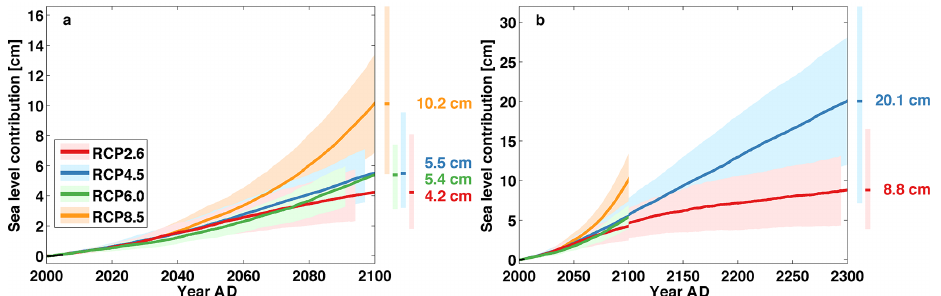
Figure 7. Greenland ice sheet contribution to future global sea-level change. Given are ensemble averages for each scenario during the 21st century (a) and the next 3 centuries (b) . The modelled rate of mass loss during the observational period (2000–2010) is on average 0.32mmyr − 1 . Colours indicate the respective RCP scenario and the lighter background colour represents 1 standard deviation from each mean trajectory. Vertical bars indicate the spread of sea-level contributions arising from individual AOGCMs at the end of each scenario. The jump across the year 2100 in the right panel arises from the use of a different number of climate models in simulations out to 2100 vs. out to 2300.